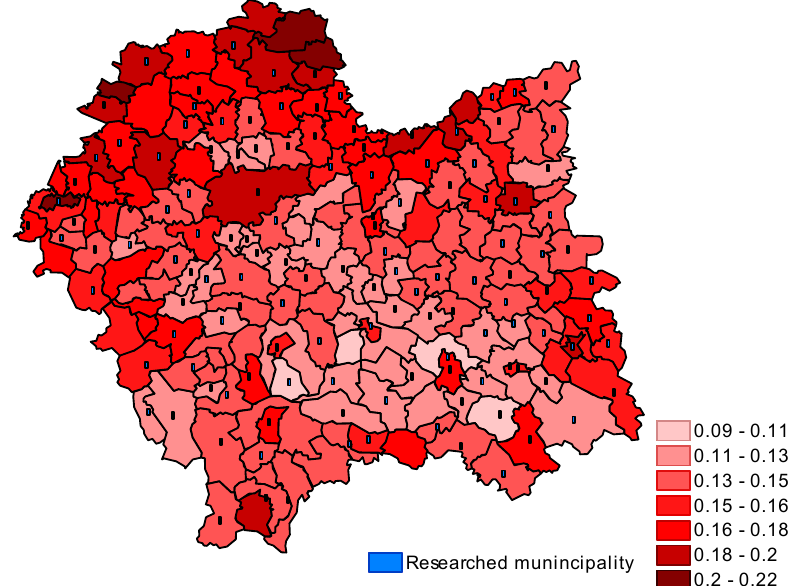
Figure 1. Age structure of municipalities in Małopolska and municipalities participating in the study (percentage of people over 65). Source: Own study based on a questionnaire survey and the Local Data Bank (https://bdl.stat.gov.pl/BDLS/pages/Home.aspx).